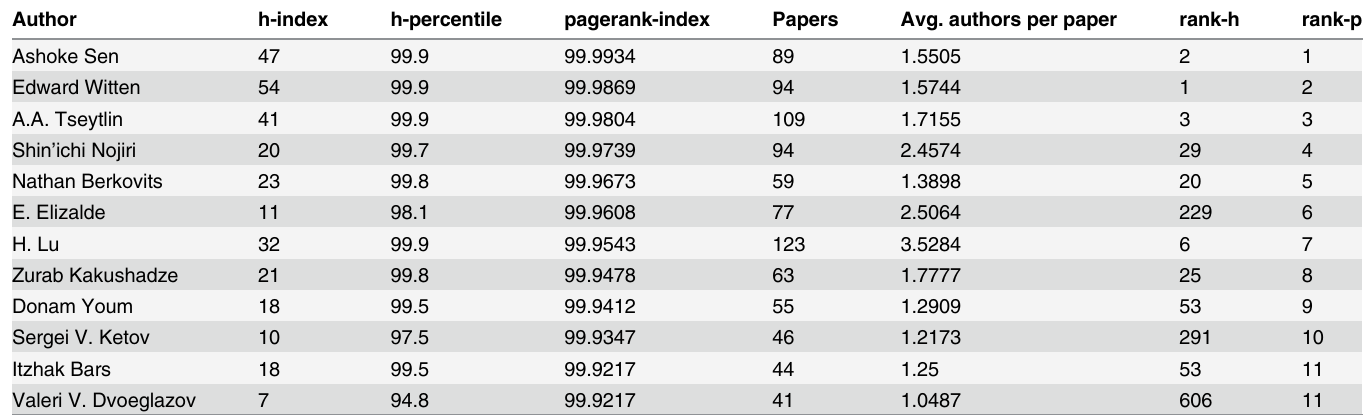
Table 4. The top 12 scientists as ordered by their pagerank-index in the HEP-TH